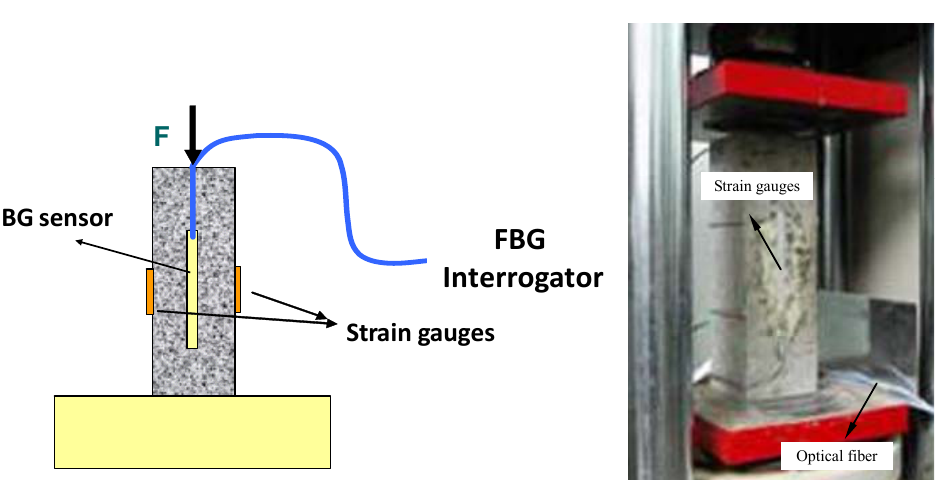
Figure 13. Compressive test of concrete column.